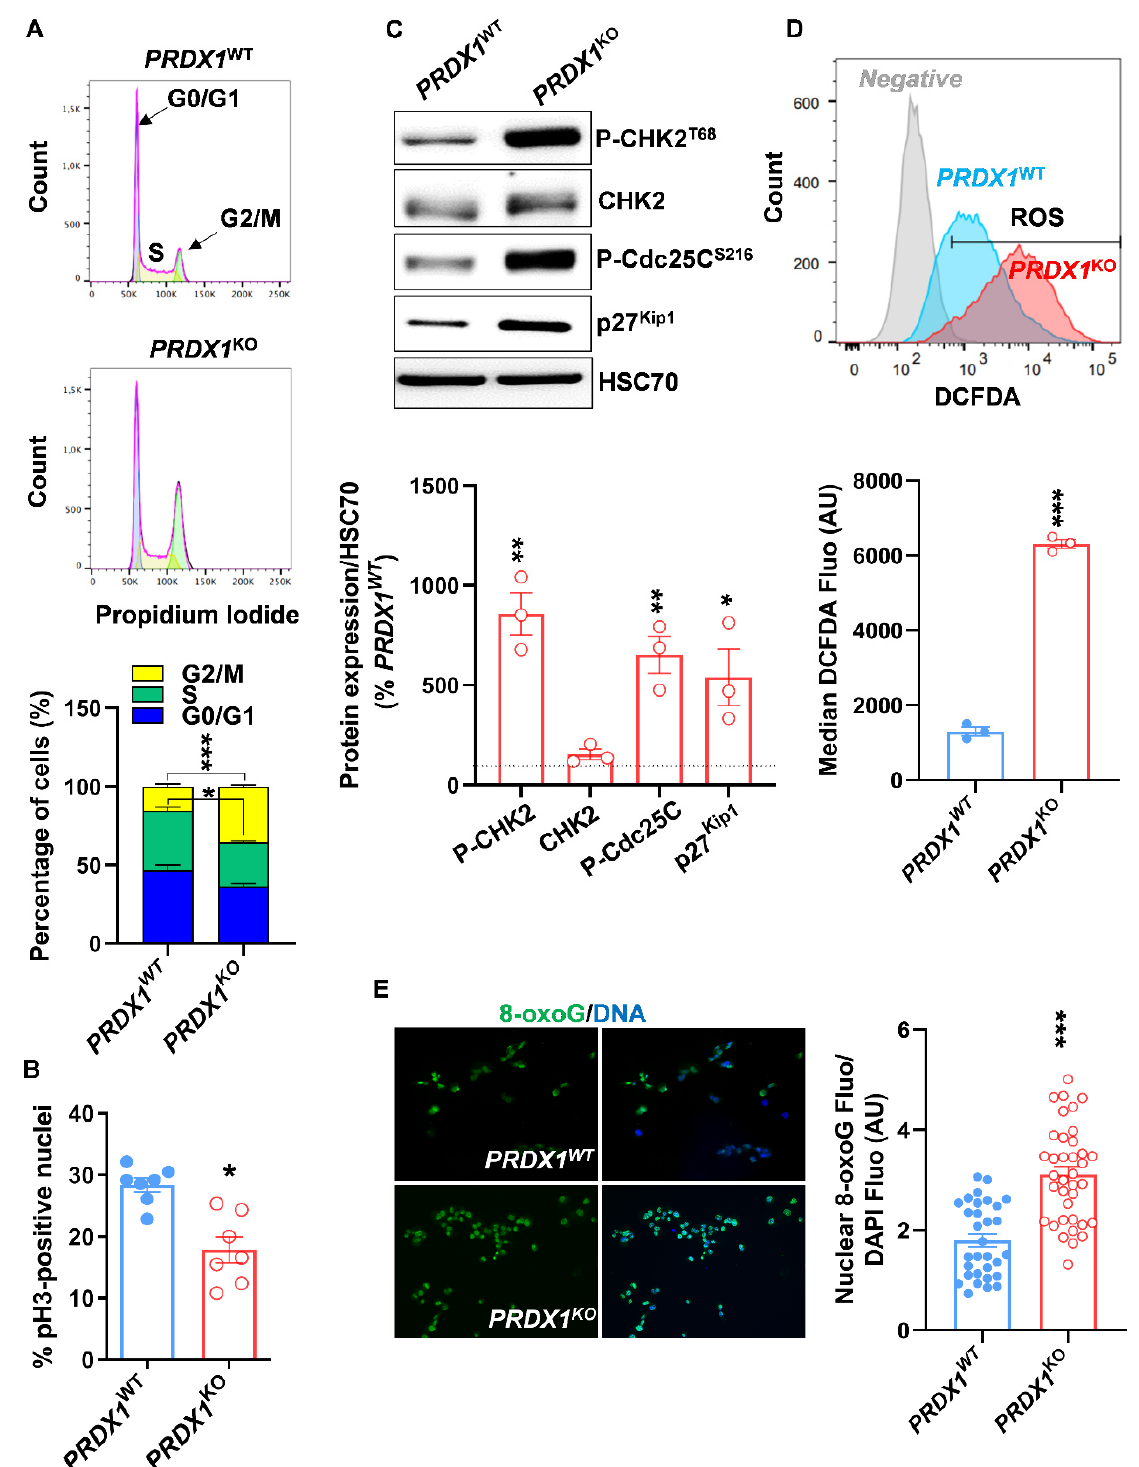
Figure 3. Peroxiredoxin-I (PRX-I) ablation causes oxidative DNA damages and cell cycle blockade in human pancreatic ductal adenocarcinoma (PDAC) cells. ( A ) Typical plots from fluorescence-activated cell sorting (FACS) analysis of cell cycle in PRDX1 WT and PRDX1 KO cells and the corresponding quantification; cell cycle analysis was performed on four independent culture passages ( n = 4). ( B ) Percentage of phospho-histone 3 (pH3)-positive nuclei quantified on immunolabeled PRDX1 WT and PRDX1 KO cells; immunolabeling was performed on three independent culture passages ( n = 3), and seven fields were randomly selected from the three experiments for pH 3 quantification. ( C ) Western blot for DNA damage markers and their corresponding densitometric quantification. Heat-shock cognate 70 (HSC70) was used as a loading control; blots were performed on three independent culture passages ( n = 3). The dashed line, set at 100%, represents the